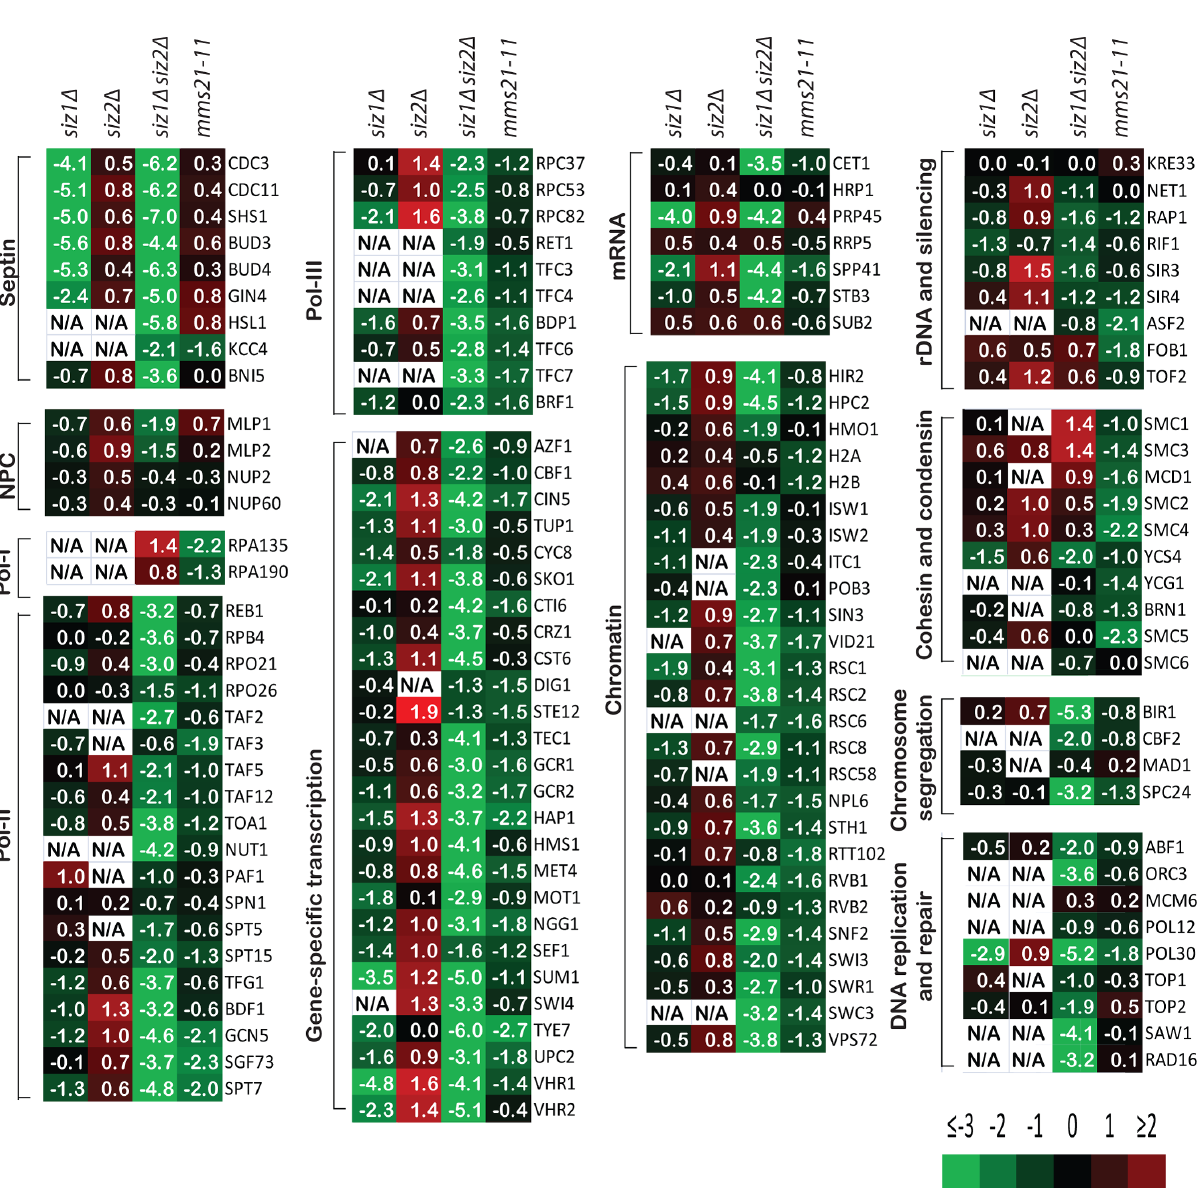
Figure 2. A summary of the effect of SUMO ligase-null mutations on the abundance of SUMO targets as measured by quantitative MS. Data are shown in the same order of siz1 D , siz2 D , siz1 D siz2 D and mms21-11 mutants from left to right for each SUMO target. Log2 scale was used to calculate the relative abundance ratios. Occasionally, some SUMO targets were not identified and are indicated as not available (N/A). Additional information can be found in Tables S3, S4, S5, S6.